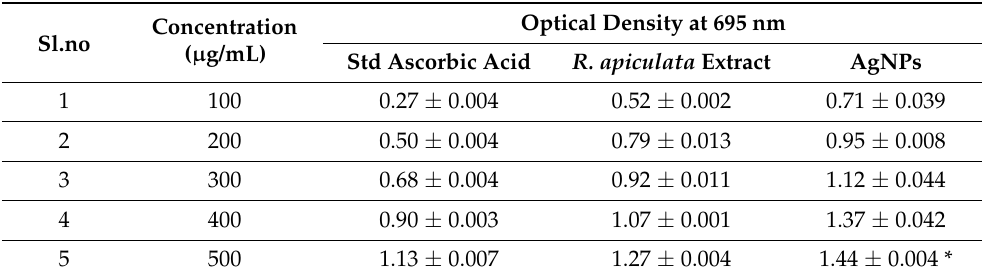
Table 5. PM assay of aqueous leaf extract of R. apiculata and its synthesized